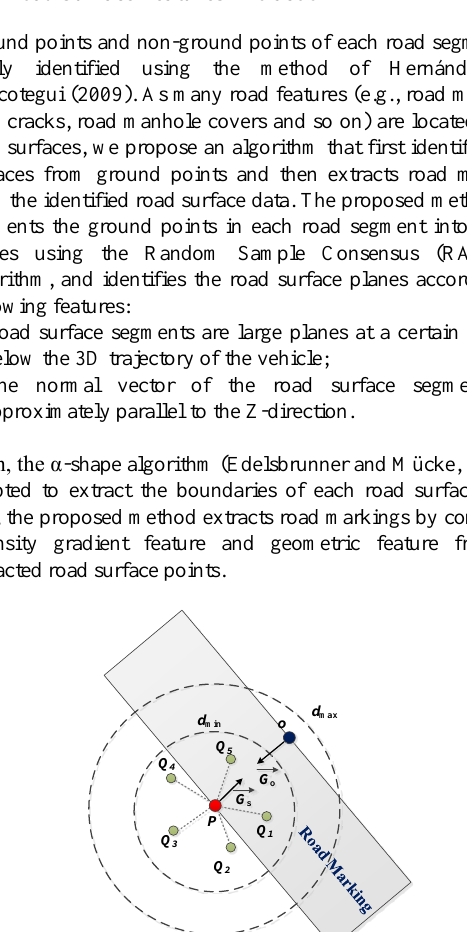
Figure 1. Overview of the proposed framework